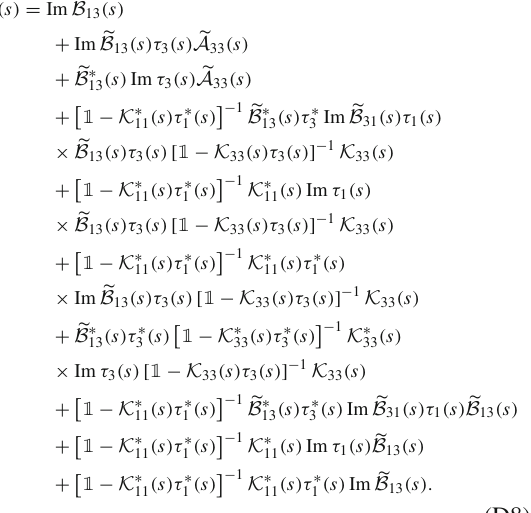
Fig. 21 The triangle diagram with loop momentum